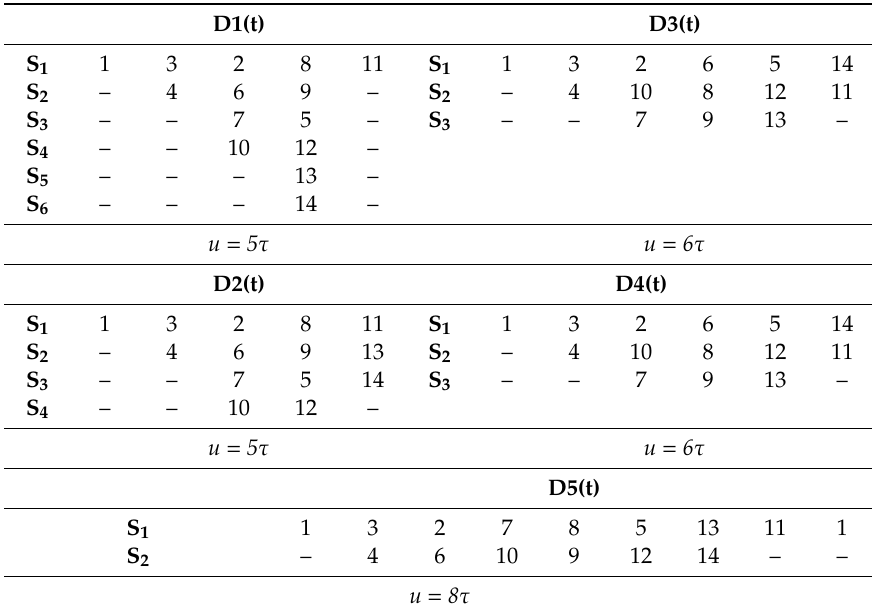
Table 4. Possible generated parallel plans for realization of the graph scheme